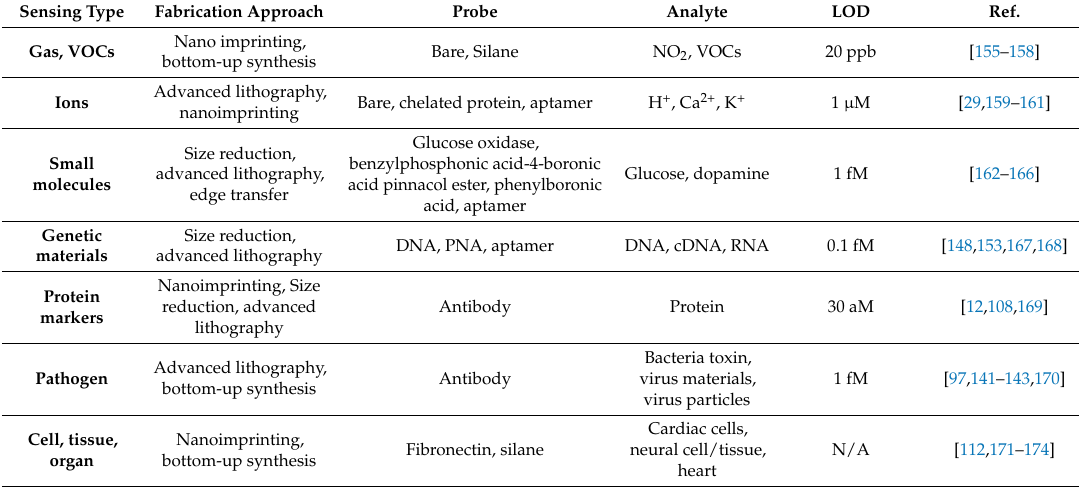
Table 2. Bioanalytical applications of SiNW FET